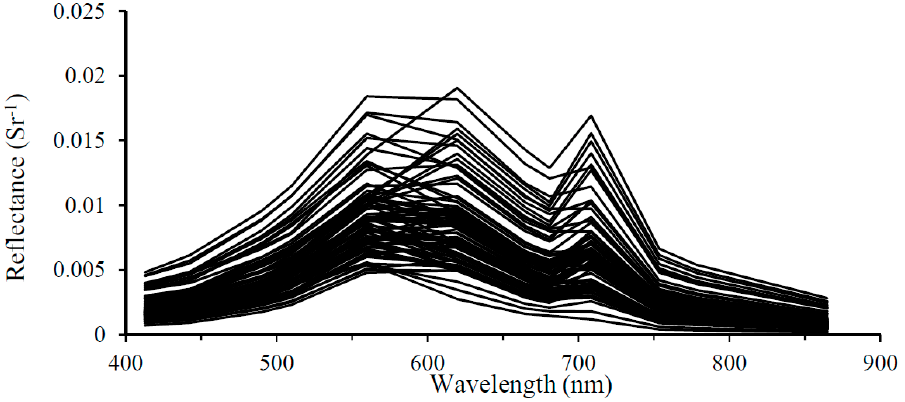
Figure 3. Atmospheric corrected remote sensing reflectance spectra for 77 stations matched the field observation in Lake Kasumigaura from 2002 to 2012.